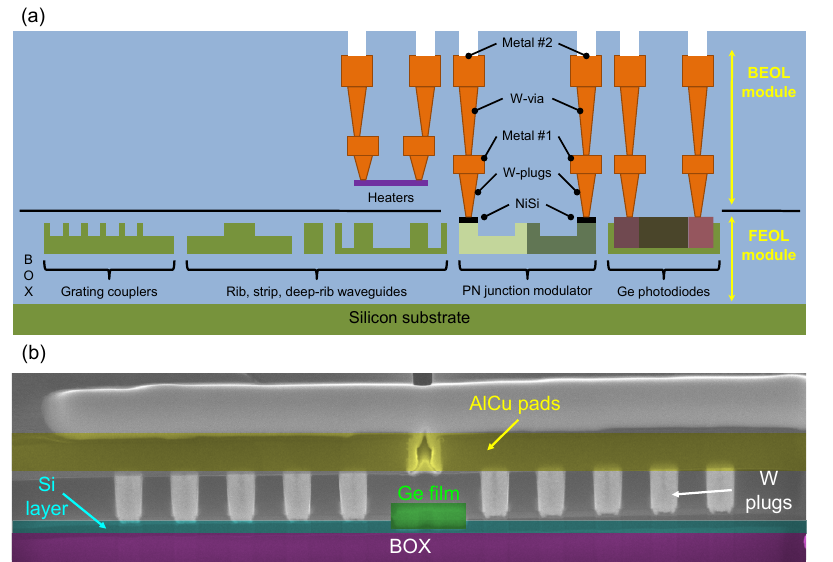
Figure 4: (a) Cross-sectional schematics of the full CEA LETI ’ s silicon photonic platform for monolithic integration of passive and active chip components. (b) Scanning electron microscopy image of chip- integrated Si – Ge photodetector with a lateral p-i-n hetero-junction.